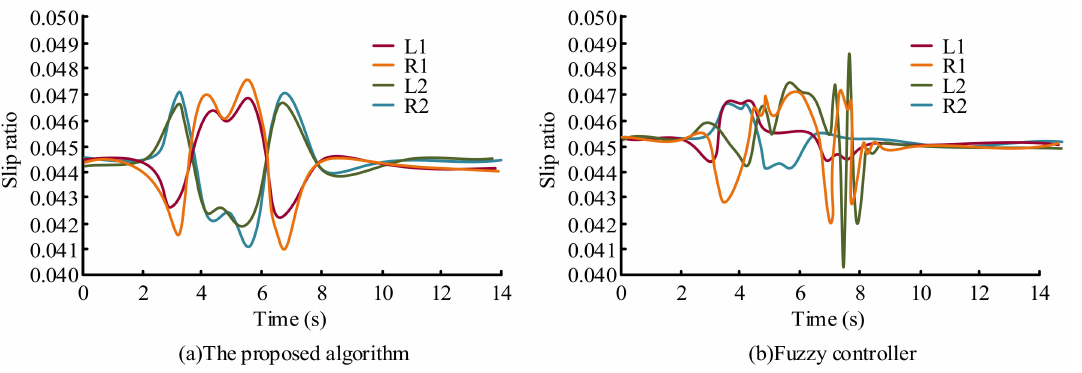
Figure 7. Performance of two regulation algorithms under double line shifting